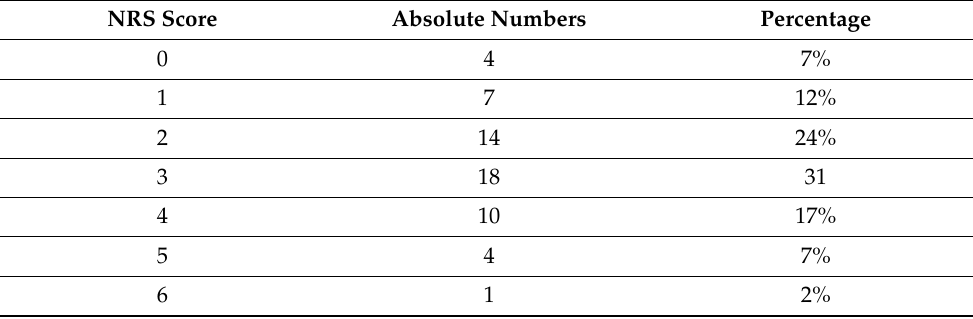
Table 6. Absolute numbers and percentages of NRS scores ( n = 58).